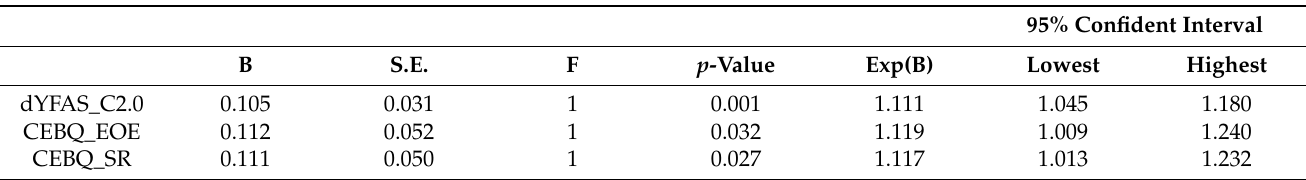
Table 3. Logistic regression analysis of food addiction and eating behaviors on problematic smart- phone use.